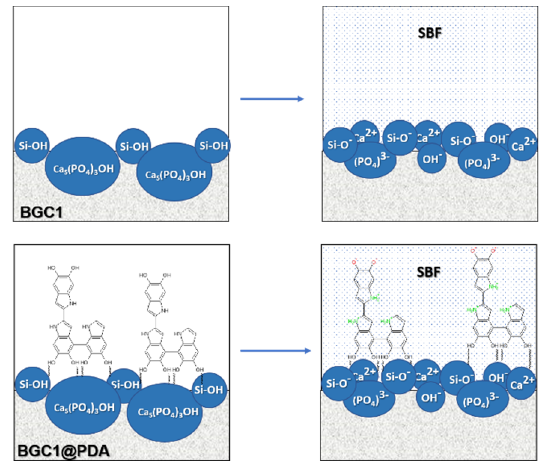
Figure 2. Schematic representations of the origin of negative charge on the uncoated (BGC1) and coated (BGC1@PDA) surface in diluted SBF at pH ≈ 7.4.